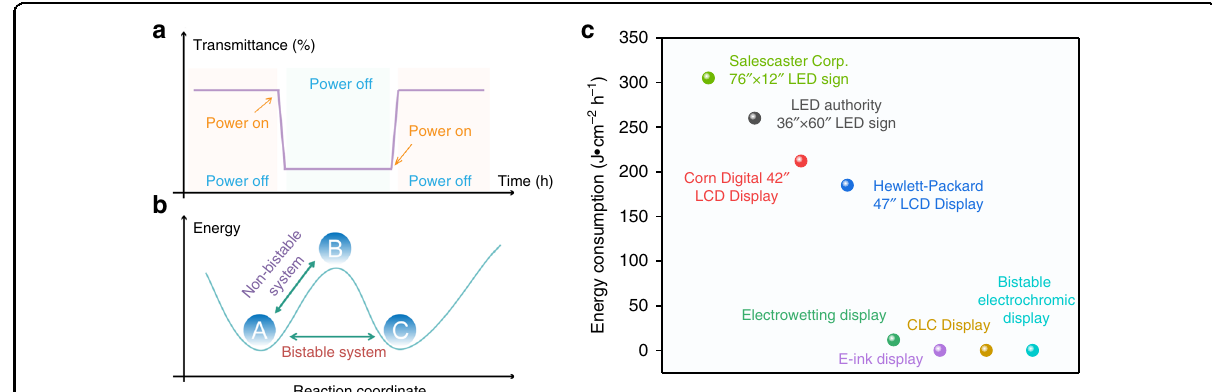
Fig. 1 Characters of the bistable display technologies. a Optical characteristics of a bistable display. b Characteristics of bistable materials at the molecular energy level. (A stands for original state of the molecule, B and C stand for different fi nal states of the molecule). c Comparison of energy consumption for different electronic displays. The energy consumption of commercialized LCDs and LEDs contains both display and heat dissipation energy